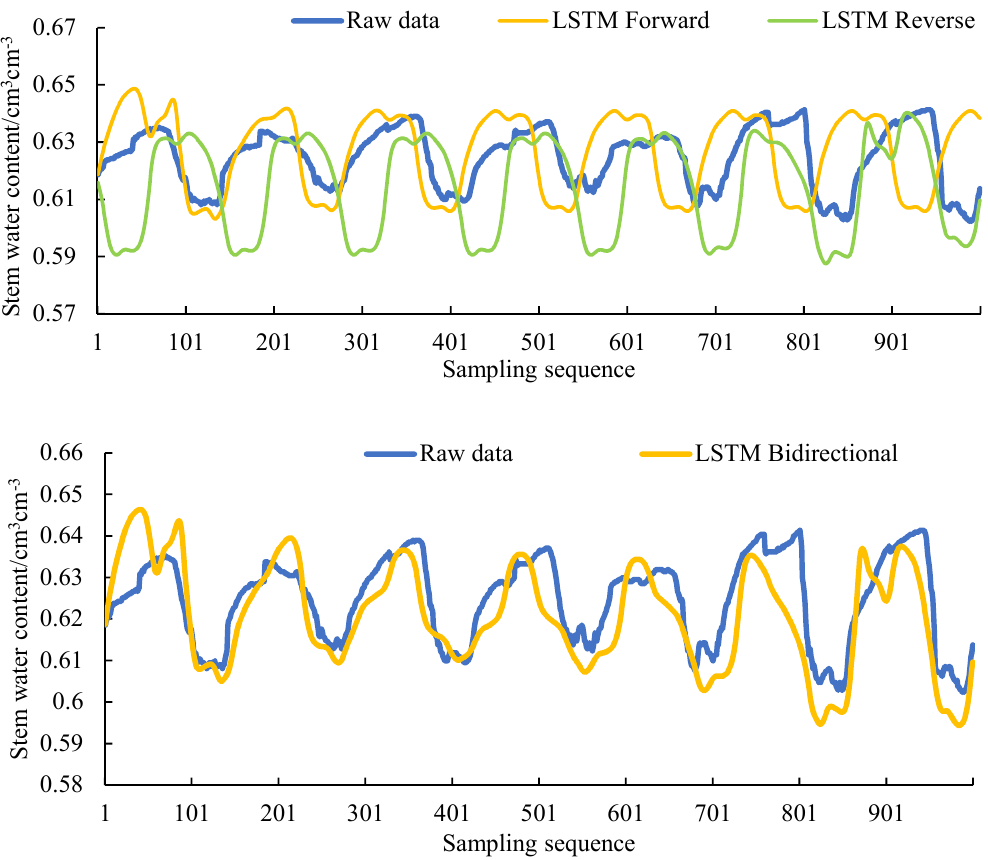
Figure 12. The 5000 training data filling results compared with the original data.